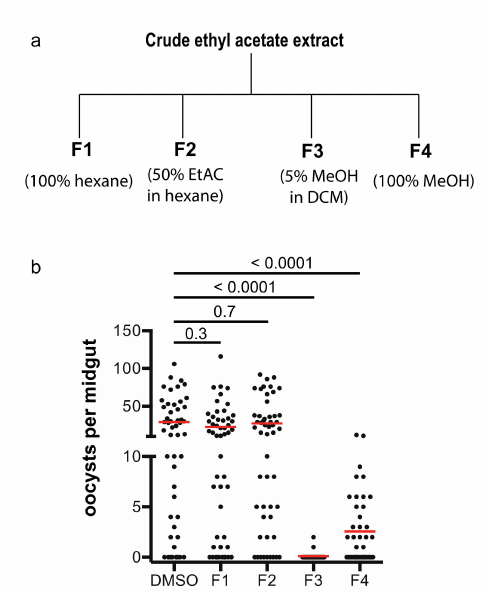
Figure 3. Fractions and activity analysis. ( a ) The crude extract was fractioned by a gravity silica column. ( b ) The activities of four fractions in inhibiting malaria transmission were determined by SMFA (standard membrane feeding